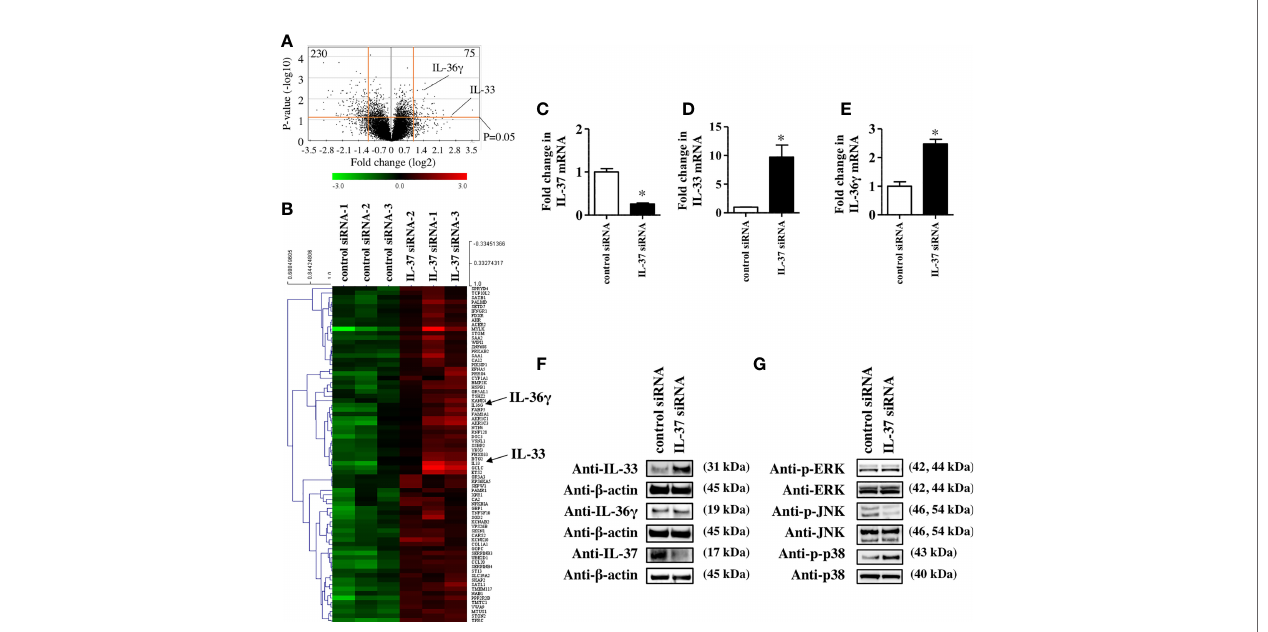
FIGURE 2 | IL-37 negatively regulated IL-33 in NHEKs. (A – G) NHEKs were transfected with either control siRNA (control siRNA) or siRNA against IL-37 (IL-37 siRNA). (A, B) Microarray analysis. (A) Volcano plot for control siRNA- and IL-37 siRNA-treated NHEKs. Average log 2 (fold change) versus log 10 (p-value) for all genes is indicated. (B) Heat map of genes in NHEKs transfected with either control siRNA (left) or IL-37 siRNA. (C – E) qRT-PCR analysis. mRNA levels of IL-37 (C) , IL-33 (D) , and IL-36 g (E) . (C – E) Data are expressed as mean ± S.E.M.; n = 3 for each group. Statistically signi fi cant differences between the expression of control siRNA- and IL-37 siRNA-transfected NHEKs are presented: *p < 0.05. (F) Western blotting analysis with anti-IL-33, -IL-36 g , or -IL-37 antibody. (G) Western blotting analysis on the phosphorylation of MAPKs. (F, G) The data are representative of experiments repeated three times with similar